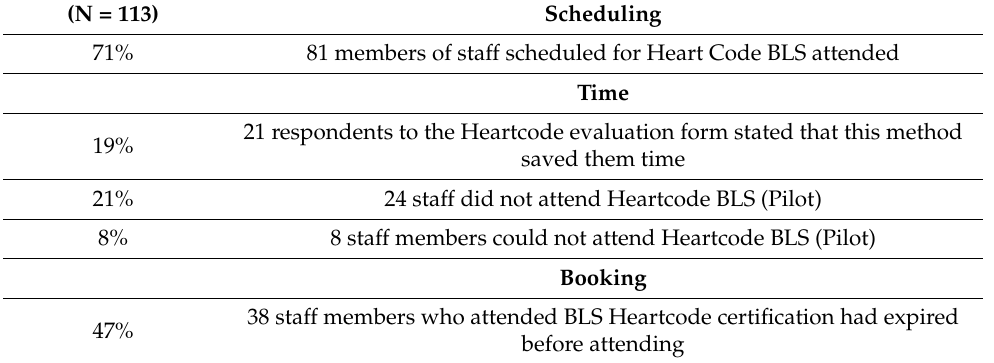
Table 8. Post Intervention